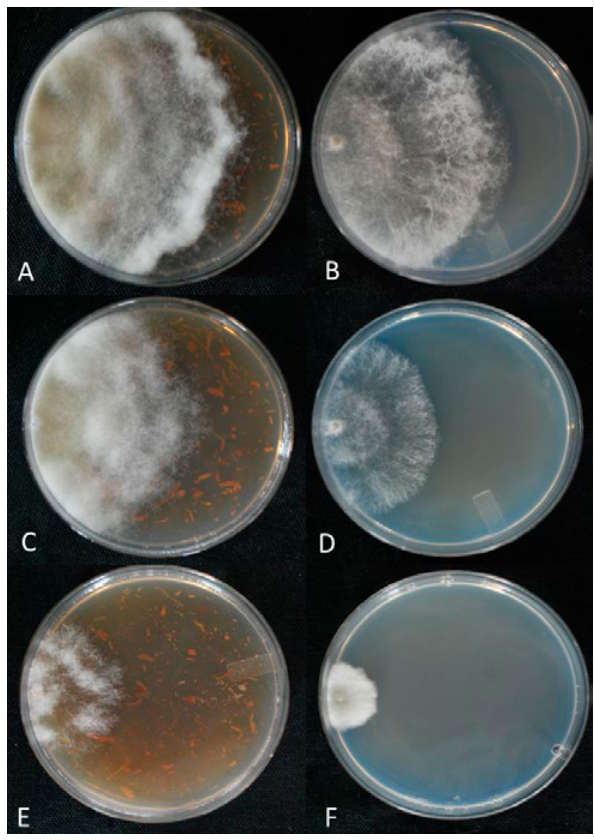
Figure 1. Mean colony diameters for three fungi on Vogel’s Mini- mum Medium with (VMM-W) (A, C, and E) or without (VMM) (B, D, and F) ground grapevine wood. The fungi were Lasiodiplodia gilaniensis (A and B), Diplodia seriata (C and D), and D. corticola (E and F). The fungi were grown for 72 h at 28°C.Visible effects were observed, mainly in D. corticola and D. seriata